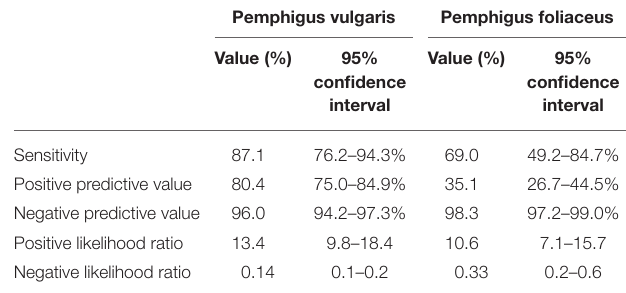
TABLE 2 | Evaluation of indirect immunofluorescence immunoassay on monkey esophagus. Pemphigus vulgaris Pemphigus